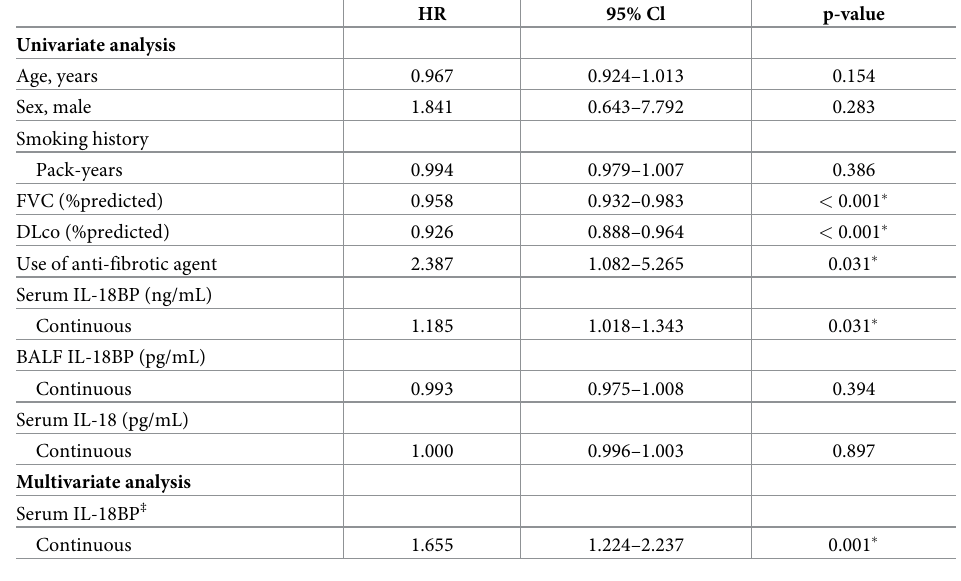
Table 3. Prediction values for 3-year mortality in IPF patients assessed by Cox proportional hazards model (n = 86).